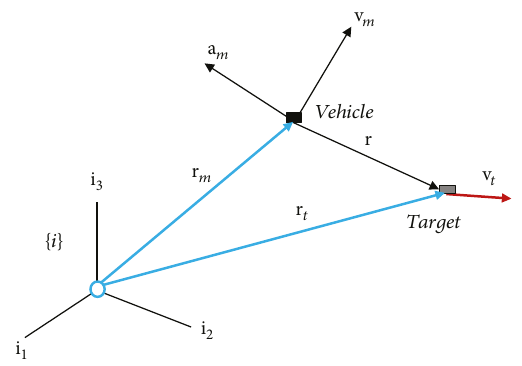
Figure 2: Pursuit geometry of the vehicle and virtual target.